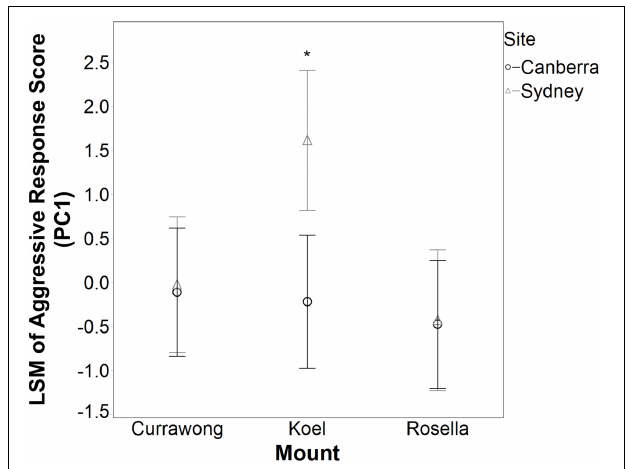
FIGURE 3 | Least square means (LSM) ± 95% CI of the Red Wattlebird aggressive response score (PC1) for each mount type in Canberra and Western Sydney. Wattlebirds in Sydney showed a significantly higher aggressive response score toward koels than any other group, as indicated by the asterisk (REML, Tukey HSD, P < 0.03 for all comparisons).